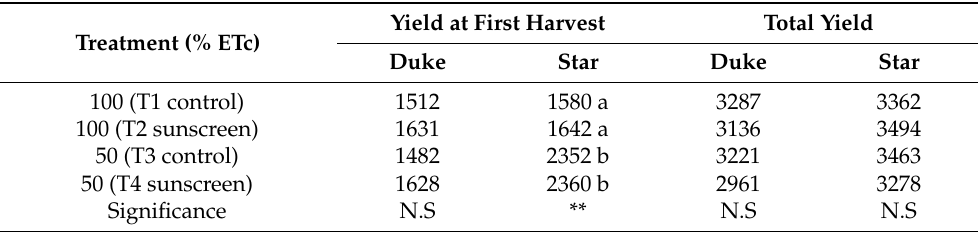
Table 6. Total yield and yield (g plant − 1 ) measured at the first harvest in the performed treatments on ‘Duke’ and ‘Star’.